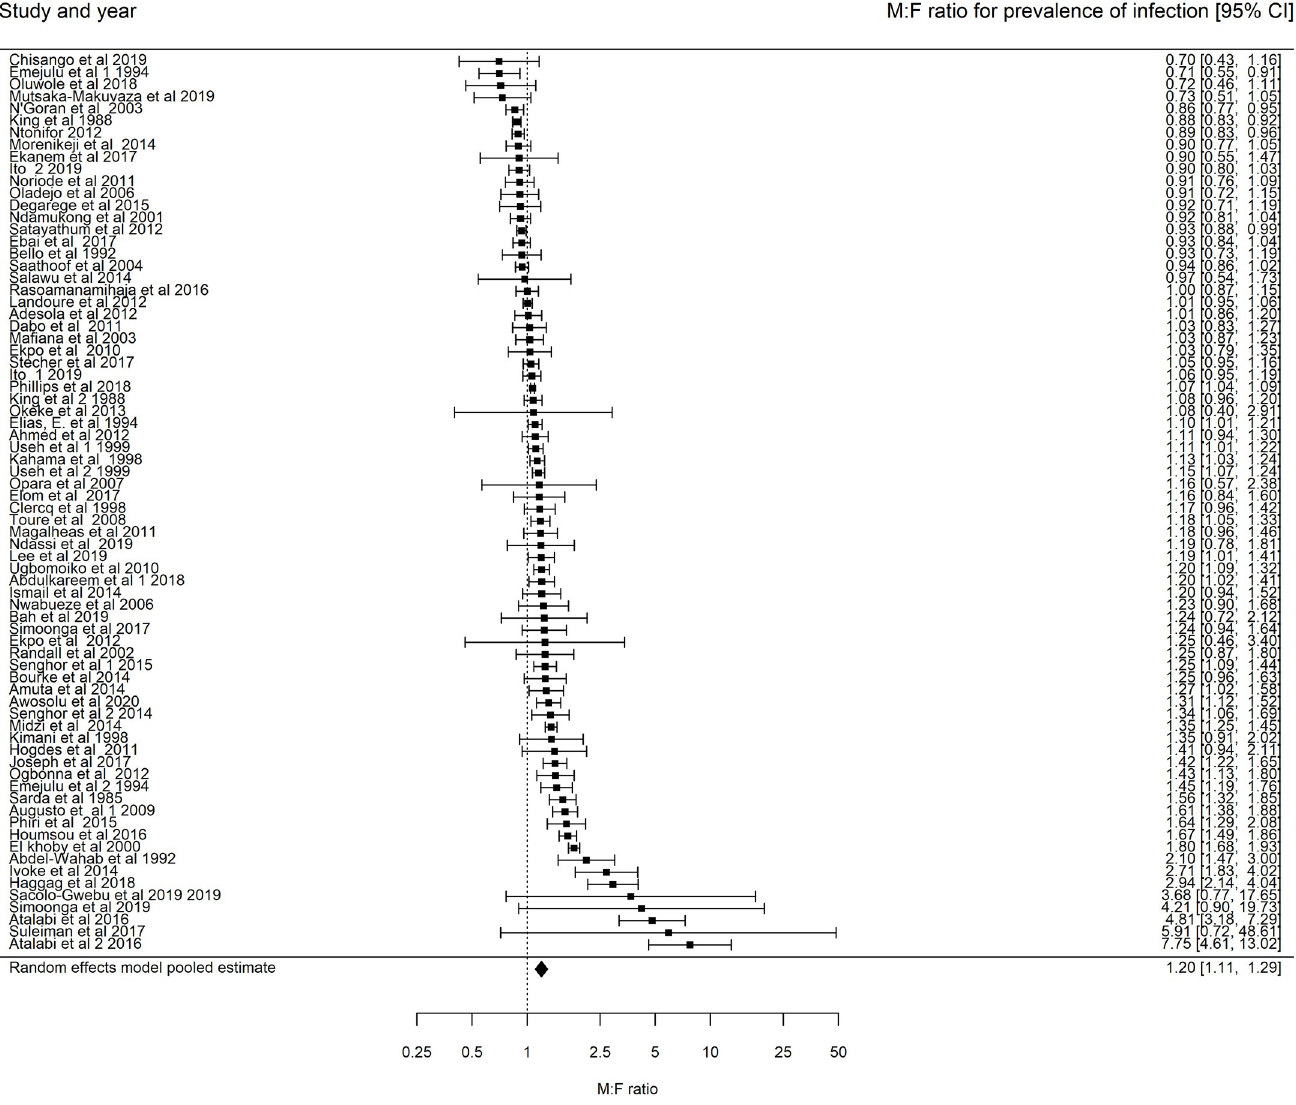
Fig 4. Forest plots showing the M:F prevalence of infection ratios and 95% CI for Schistosoma haematobium (74 communities and n = 71 studies, pooled M:F prevalence ratio is (1.19, 95% CI 1.11–1.29), heterogeneity: I 2 = 95.95%). Points further to the right indicate higher prevalence in males.Analysis includes studies that report the number of males and females who were screened for S. haematobium infection and the fraction who tested positive regardless of the reported significance of the difference in M:F prevalence of infection ratios. The M : F intensity of infection ratios in the 35 studies that reported it ranged from 0.55 to 2.79 observed in a study in Sudan [73] and a study in Uganda [23] respectively. Only one of these were statistically significant: the study in Uganda where males had on average three times higher egg counts than females. Males had a higher mean intensity of infection in all but one study that reported a significant difference in intensity of infection between males and females. This study was in a community in Sudan [64] where females had higher egg counts than males even though the observed prevalence was significantly higher in males. This was attributed to the duration spent on household chores such as laundry at the local canal by females in the study population.